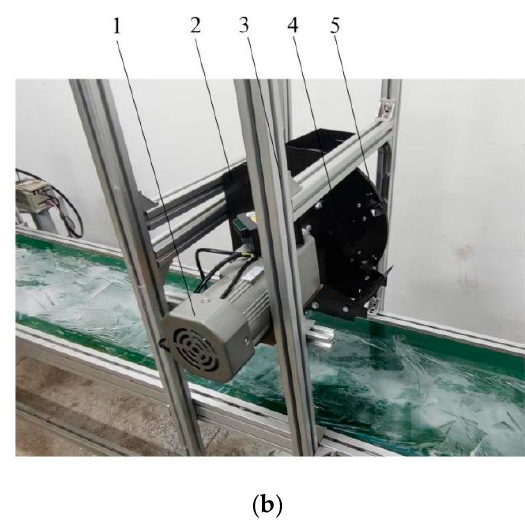
Figure 7. Test materials and bench. ( a ) Garlic of Pizhou; ( b ) 1. motor governor; 2. seed-filling chamber; 3. mounting rack; 4. seeding tray; 5. seed-taking device. Table 4. Factors and levels of test.